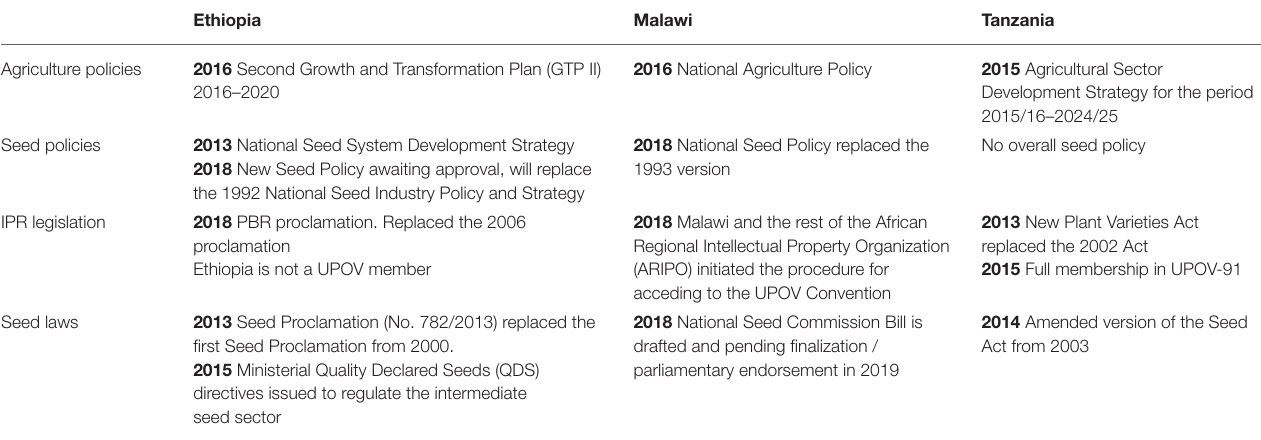
TABLE 1 | Policies and laws important for seed system governance in Ethiopia, Malawi and